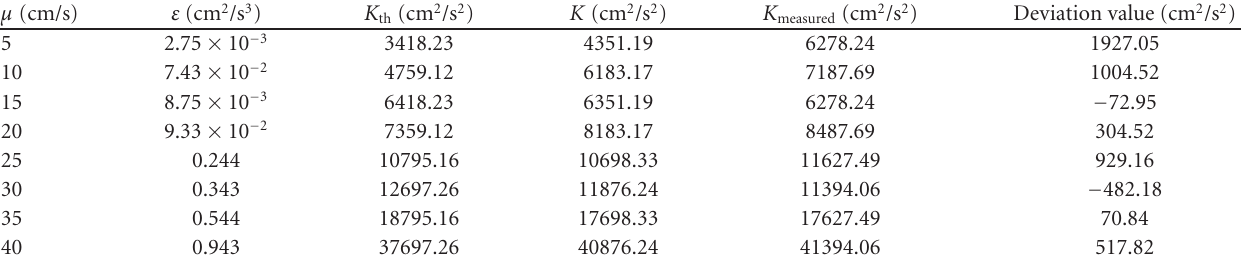
Table 1: Computation process and result comparison of turbulence parameter in di ff erent experimental condition by using k - ε model.